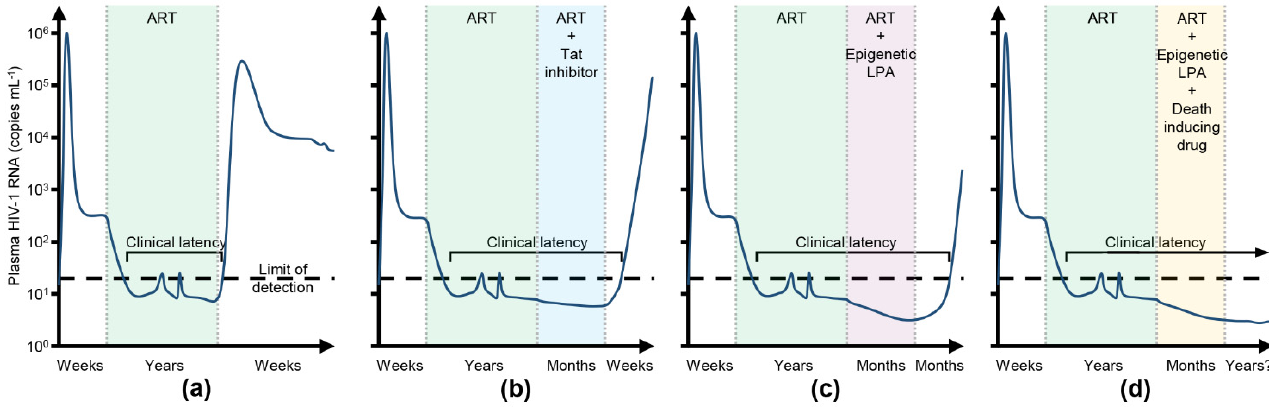
Figure 2. Potential strategy to achieve an HIV-1 cure. ( a ) Antiretroviral therapy (ART) suppresses HIV-1 plasma viremia, but upon interruption of ART, it quickly rebounds; ( b ) conventional HIV-1 Tat/P-TEFb inhibitors fail to silence epigenetically the HIV-1 promoter, thus when they are removed, transcription is eventually restored and HIV-1 viremia rebounds; ( c ) supplementation of ART with a latency-promoting epigenetic silencing drug (LPA) could promote a state of deep latency, but as they do not reduce the viral reservoir, rebound could occur; ( d ) supplementation of ART with both an LPA and a drug that selectively kills HIV-1 infected cells could decrease the size of the viral reservoir, significantly prolonging the time to viral rebound after ART interruption. Optimization of such a strategy has the potential to completely eliminate the viral reservoirs.